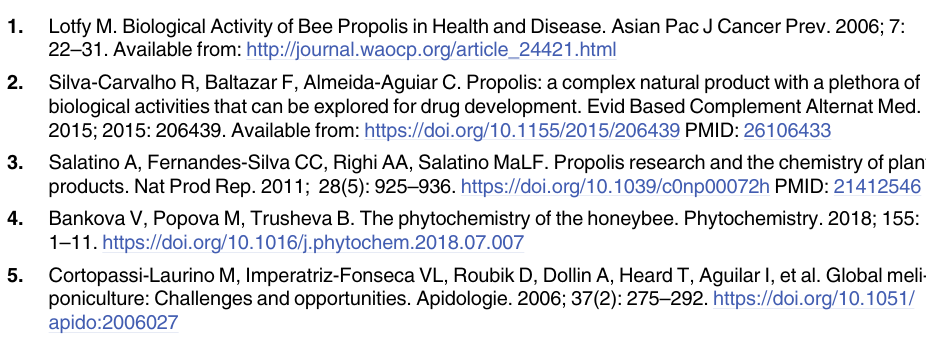
OD. 3 OD. 3 . 3 . 3 3